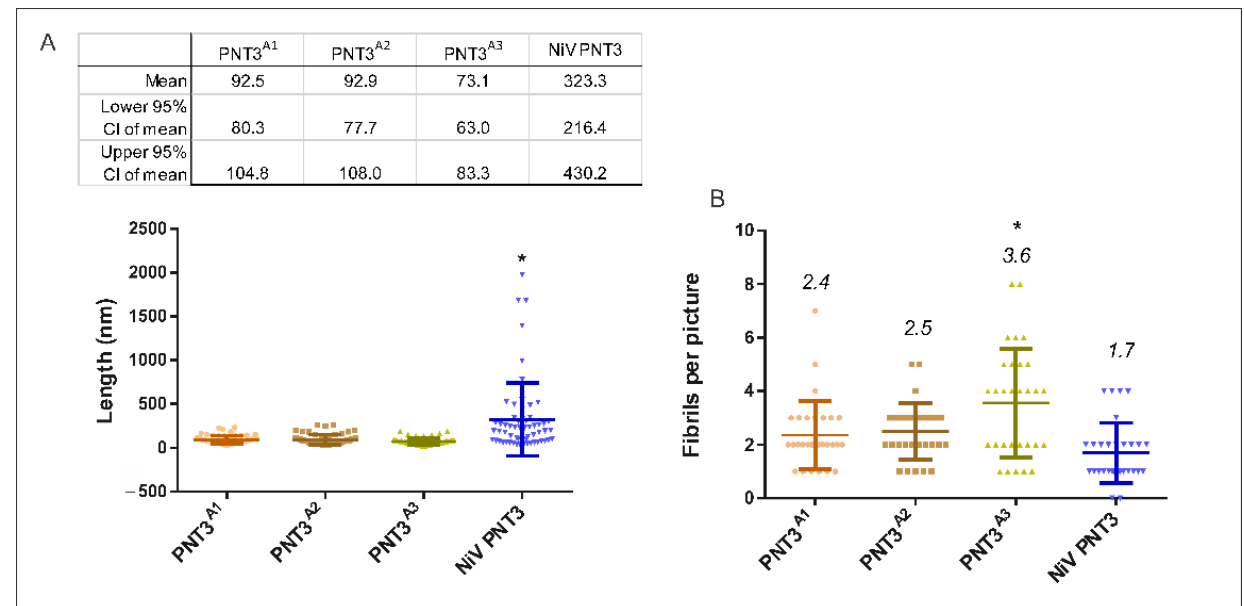
Figure 7. Fibril length of EYYY variants. ( A ) For each variant, statistics on fibril length were obtained from analysis of the contour length of 60 fibrils after 96 h of incubation at 37 ◦ C. The upper table shows the main statistical results. ( B ) Number of fibrils detected per picture for each variant. Upper number indicates the mean value of each variant. The analysis was done using the ImageJ software. The asterisk indicates statistically significant differences (One-way Anova test, p -value < 0.05). Circles: PNT3 A1 ; squares: PNT3 A2 ; triangles: PNT3 A3 , inverted triangles: NiV